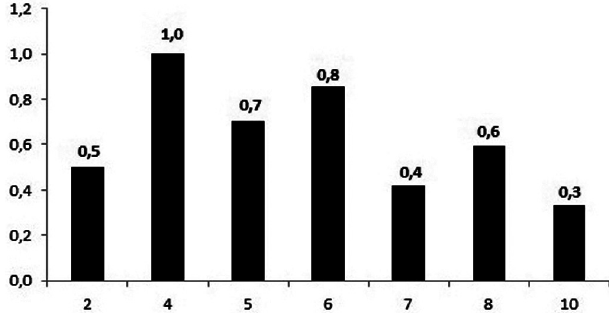
Fig. 1 – Graph showing the relative expression of endothelin 1 (ET-1) in mitral valves samples 2, 4, 5, 6, 7, 8 and 10